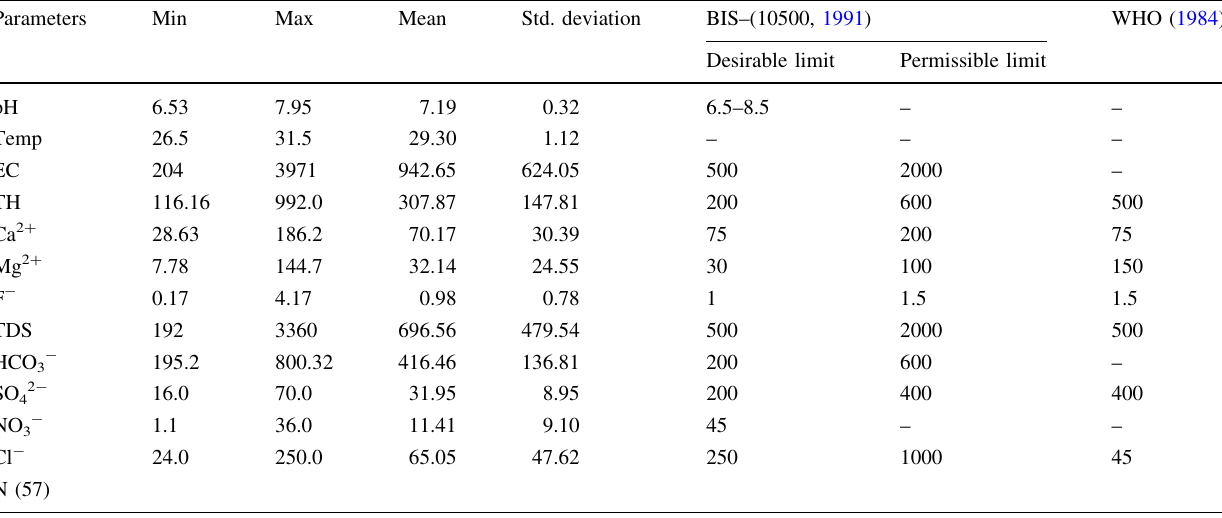
The anion and cation values shown in mg/l, temperature in (cid:3) C and EC in l S/cm at 25 (cid:3) C